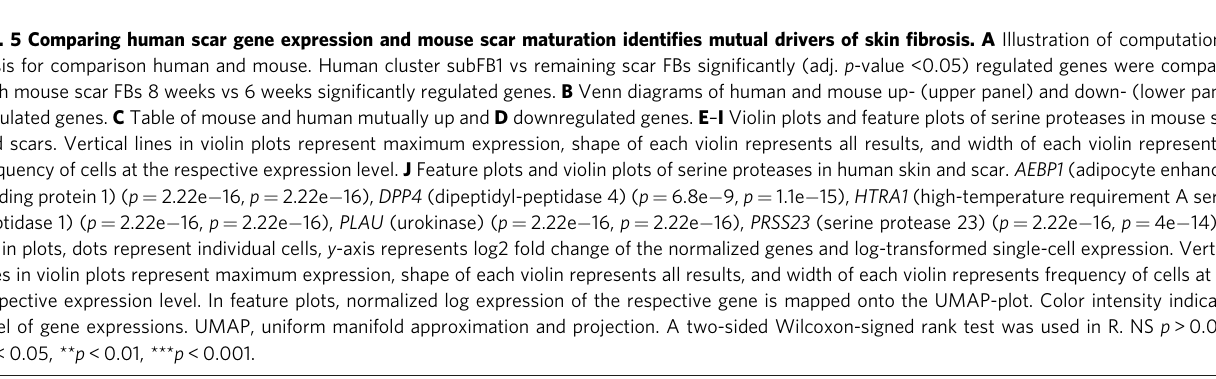
Fig. 5 Comparing human scar gene expression and mouse scar maturation identi fi es mutual drivers of skin fi brosis. A Illustration of computational basis for comparison human and mouse. Human cluster subFB1 vs remaining scar FBs signi fi cantly (adj. p -value <0.05) regulated genes were compared with mouse scar FBs 8 weeks vs 6 weeks signi fi cantly regulated genes. B Venn diagrams of human and mouse up- (upper panel) and down- (lower panel) regulated genes. C Table of mouse and human mutually up and D downregulated genes. E – I Violin plots and feature plots of serine proteases in mouse skin and scars. J Feature plots and violin plots of serine proteases in human skin and scar. AEBP1 (adipocyte enhancer- binding protein 1) ( p = 2.22e − 16, p = 2.22e − 16), DPP4 (dipeptidyl-peptidase 4) ( p = 6.8e − 9, p = 1.1e − 15), HTRA1 (high-temperature requirement A serine violin plots, dots represent individual cells, y -axis represents log2 fold change of the normalized genes and log-transformed single-cell expression. Vertical lines in violin plots represent maximum expression, shape of each violin represents all results, and width of each violin represents frequency of cells at the respective expression level. In feature plots, normalized log expression of the respective gene is mapped onto the UMAP-plot. Color intensity indicates level of gene expressions. UMAP, uniform manifold approximation and projection. A two-sided Wilcoxon-signed rank test was used in R. NS p >